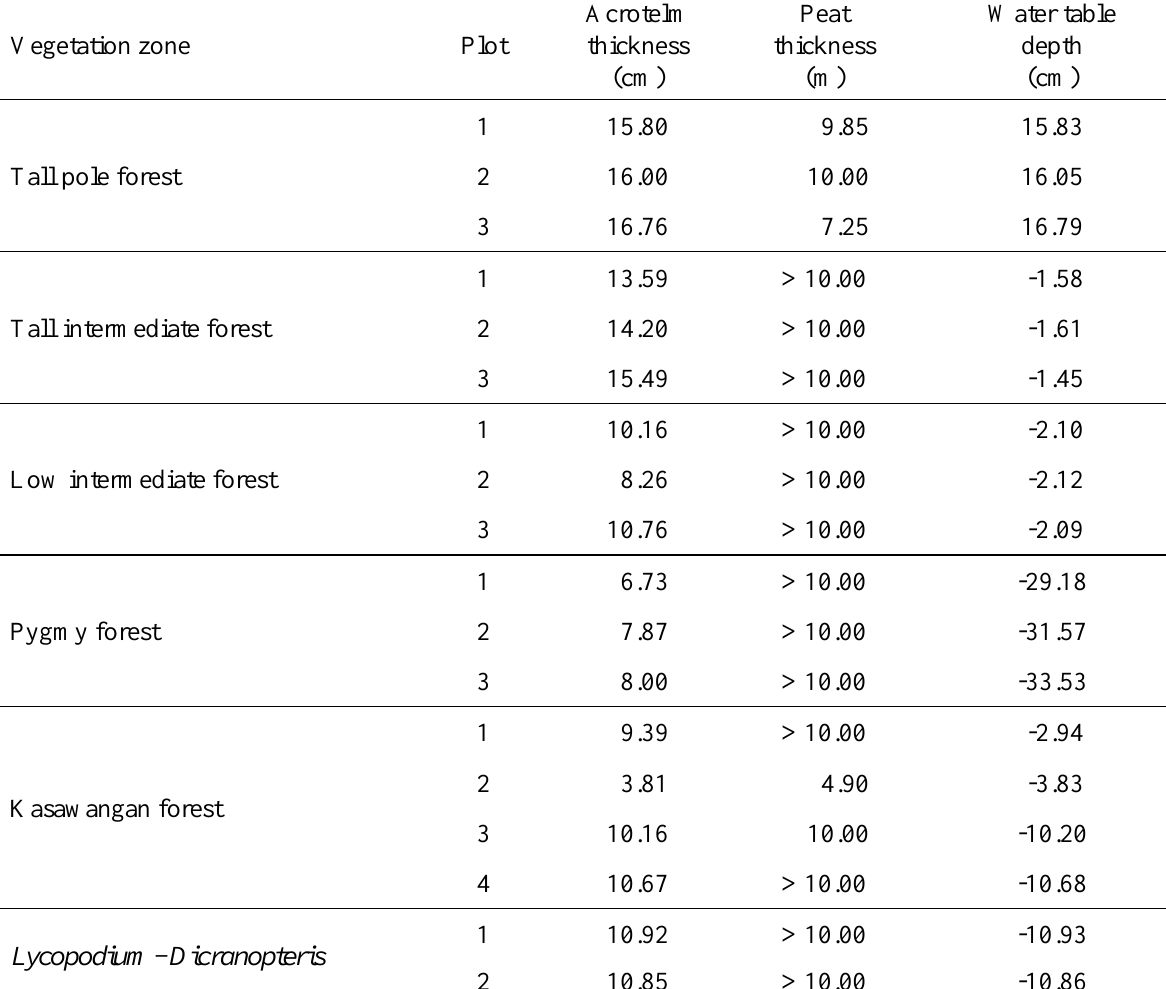
Table 1. Physical characteristics of peat and water table in the different forest subtypes of the Caimpugan peat swamp forest. Negative water table depth measurements indicate the depth of flooding of the ground